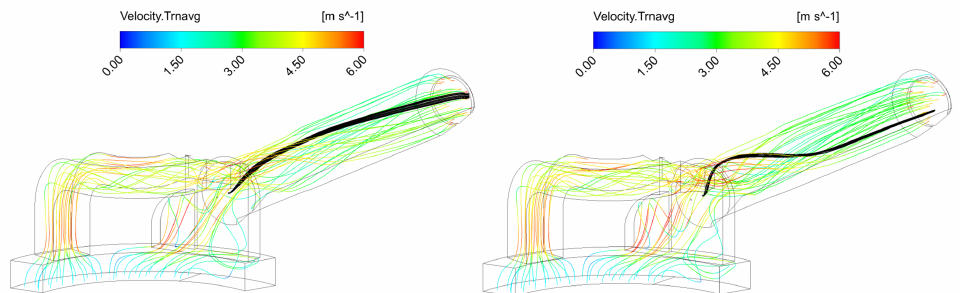
Figure 13. Time-averaged streamlines in the kiln, where the black streamlines show the predicted trajectory of the burner jet. Results from the two-equation turbulence model, with k − ε to the left and the Reynolds stress model RSM-BSL to the right. Figure adapted from [11]. Reprinted with permission from the Society for Mining, Metallurgy &